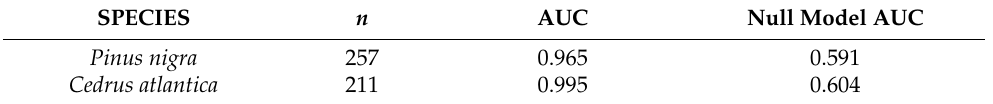
Table 1. Evaluation of the distribution models: observed and null model AUC. SPECIES n AUC Null Model AUC Pinus nigra 257